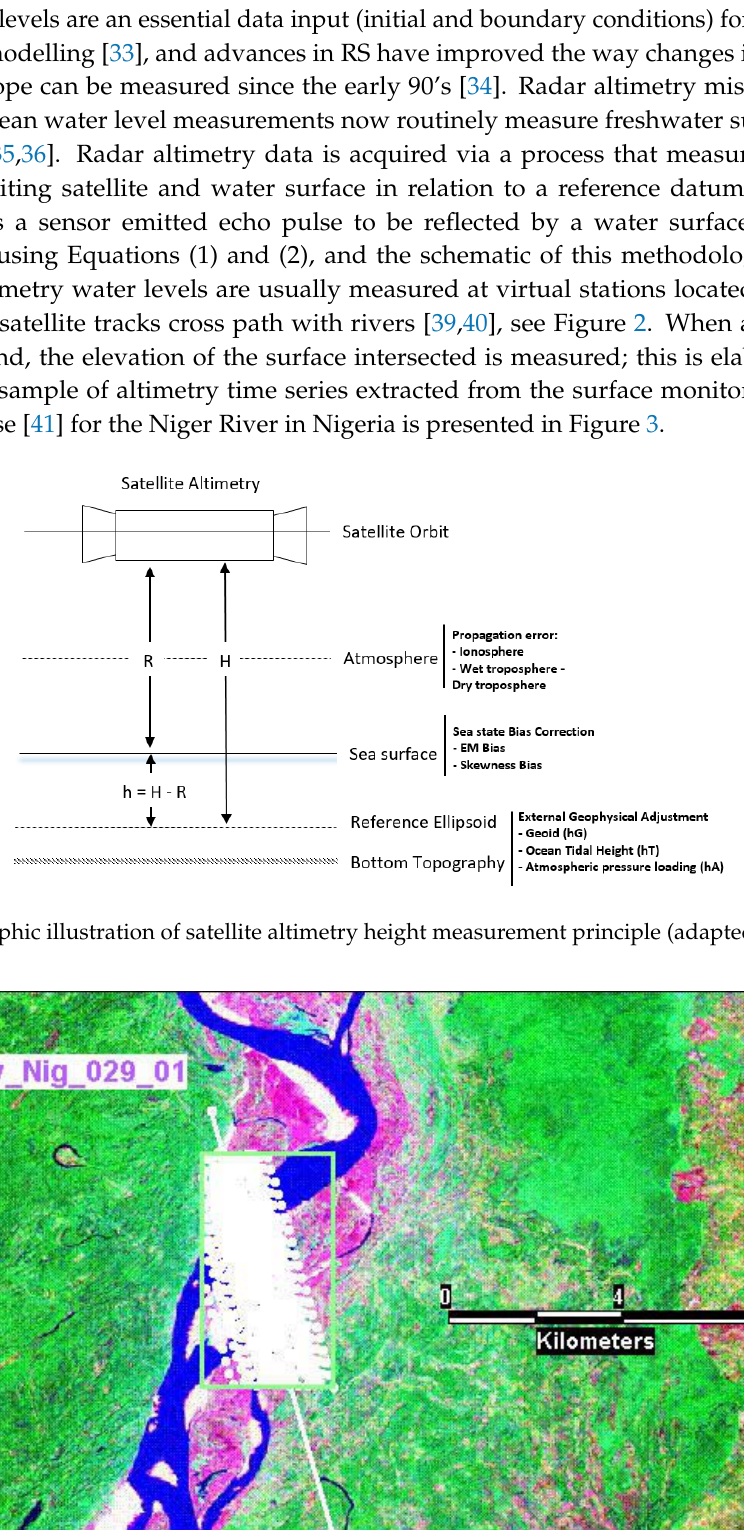
Figure 3. Typical water level time ‐ series extracted from an altimetry virtual station along the river Niger (error bars indicate standard deviation from water level height (m), and are low during peak flooding, as altimetry measurement accuracy is improved during this season [42]. The water level at a river of interest with reference to a predefined datum (such as Earth Gravitational Model (EGM 2008)), is expressed as: (cid:1860) (cid:3404) (cid:1834) (cid:3398) (cid:1844) (cid:3004)(cid:3042)(cid:3045)